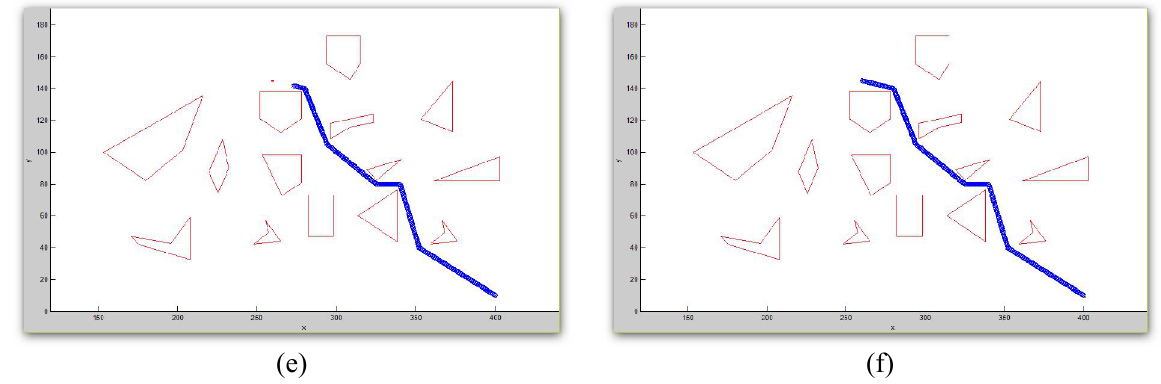
Fig. 5. The SPP algorithm helps the robot in generating the optimal path